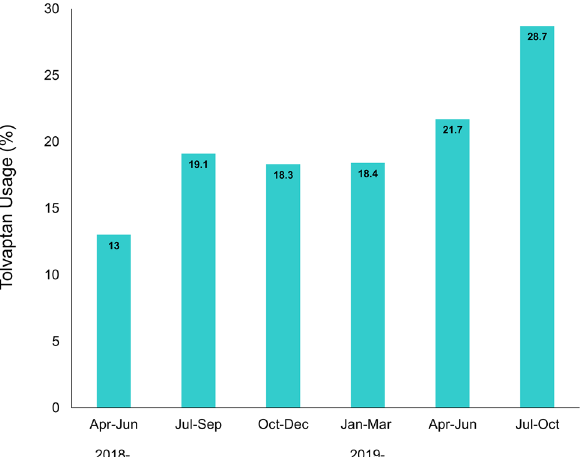
Figure 2. Temporal trend for tolvaptan usage after revision of the JCS/JHFS guidelines. The usage of tolvaptan in the acute setting increased steadily but no statistical significance ( p for trend = 0.07).